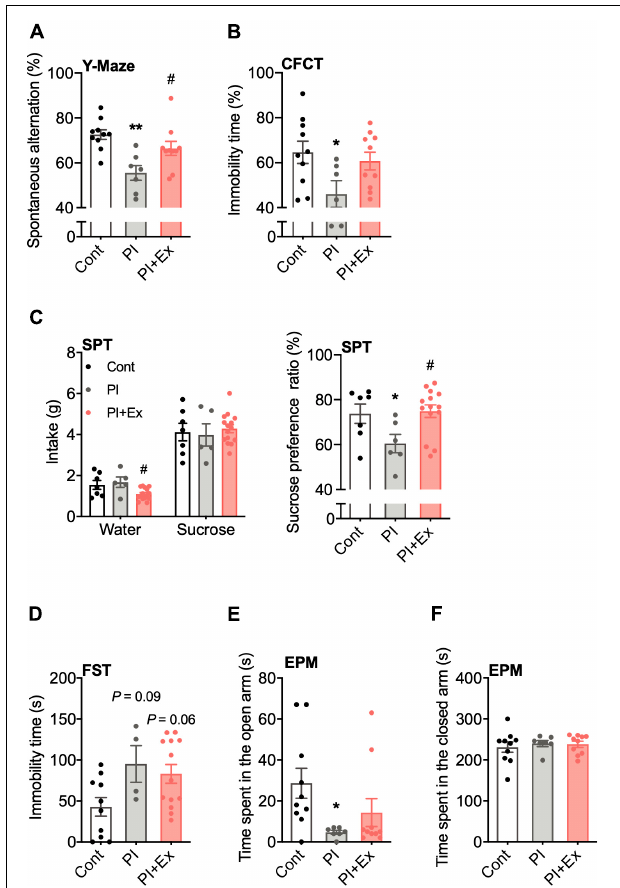
FIGURE 7 | Regular low-intensity exercise prevents cognitive decline and depressive state due to physical inactivity. (A) Accuracy rate in the Y-maze test. (B) Immobility time in the contextual fear conditioning test (CFCT). (C) Sucrose preference ratio in the sucrose preference test (SPT). (D) Immobility time in the forced swim test (FST). (E,F) Time spent in the open and closed arm in the elevated plus-maze test (EPM). All data are presented as the mean ± SEM (Cont mice, n = 10; PI mice, n = 7; PI + Ex mice, n = 10). Data were analyzed using one-way ANOVA with Tukey’s post-hoc test. *p < 0.05, **p < 0.01 in compared with the Cont mice and # p < 0.05 in comparison with the PI mice.